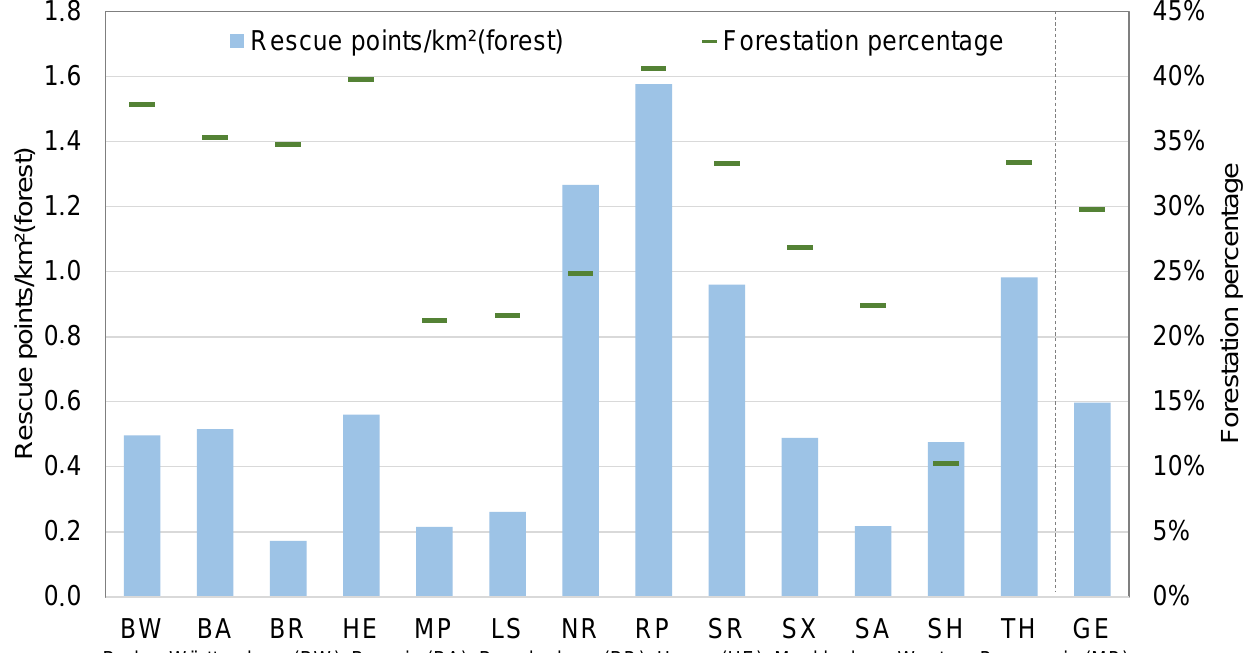
Figure 5. Density of German rescue points in the forest and forestation percentage per federal states Figure 1. Dense of German rescue points in the forest and forestation percentage per and federal federal states.